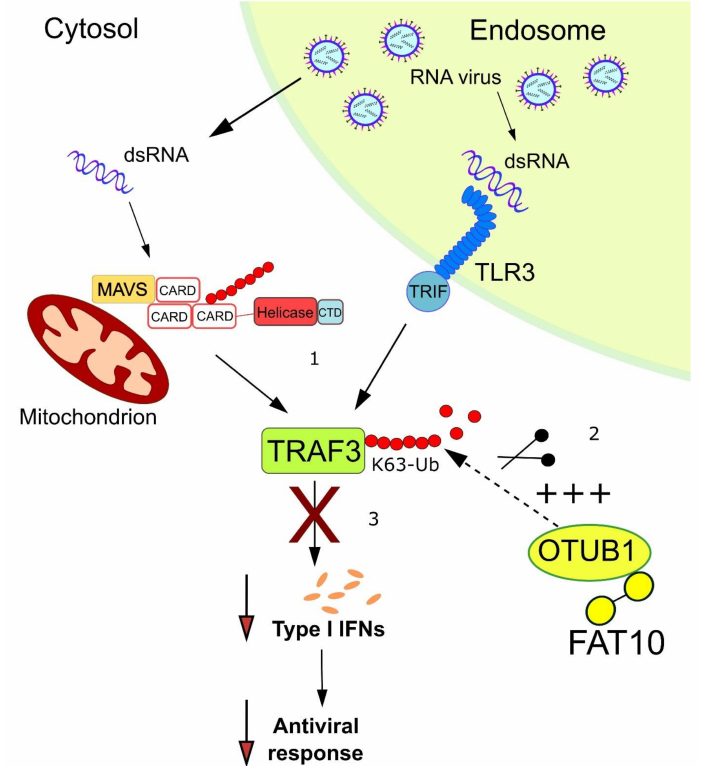
Figure 5. FAT10 stimulates the activity of OTUB1 in deubiquitylating TRAF3. 1. dsRNA is sensed by the cytosolic RNA sensor RIG-I and by the endosomal receptor TLR3, resulting in the activation of TRAF3 by K63-linked autoubiquitylation. 2 . FAT10 is expressed upon TNF α / IFN- γ stimulation and interacts with the deubiquitylating enzyme OTUB1. This non-covalent interaction enhances the activity of OTUB1, which becomes more e ffi cient in removing K63-linked ubiquitin from TRAF3. 3 . The deubiquitylation of TRAF3 counteracts the optimal continuation of the type-I interferon response, possibly resulting in an attenuated anti-viral